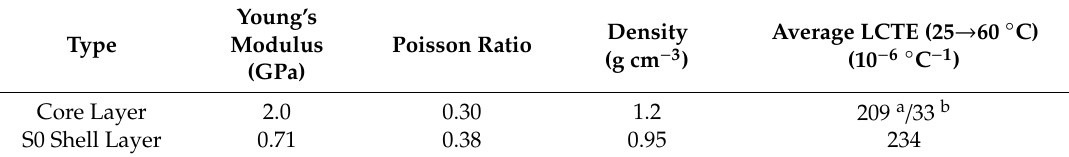
Table 3. The measured parameters of wood polymer composite (WPC) core and shell layers at 25 ◦ C were used for finite element analysis